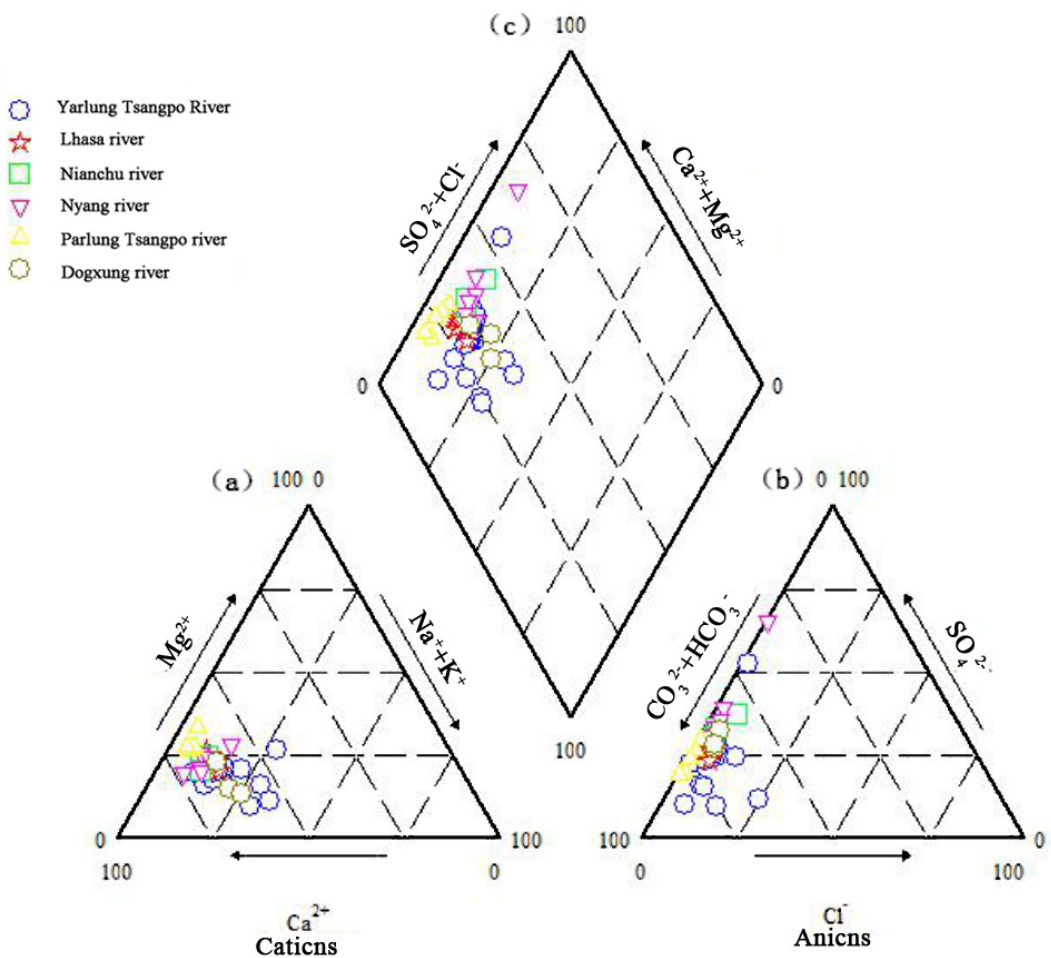
Figure 4. Ternary plot of dissolved anions and cations on an equivalent concentration (leq/L) basis in the Yarlung Tsangpo River and its tributaries. Each symbol corresponds to streams from the main tributaries analyzed in this study: the Lhasa river, Nianchu river, Nyang river and Parlung Tsangpo. ( a ) Cation plot: most of the samples cluster around Ca 2+ apex, indicating dominance of carbonate weathering contribution to major ion concentrations. ( b ) Anion plot: data near the mixing line between HCO 3 − + CO 3 2 − , suggesting carbonate and evaporite weathering in these basins. ( c ) Diamond plot: most of the samples cluster around SO 4 2 + Cl − apex.